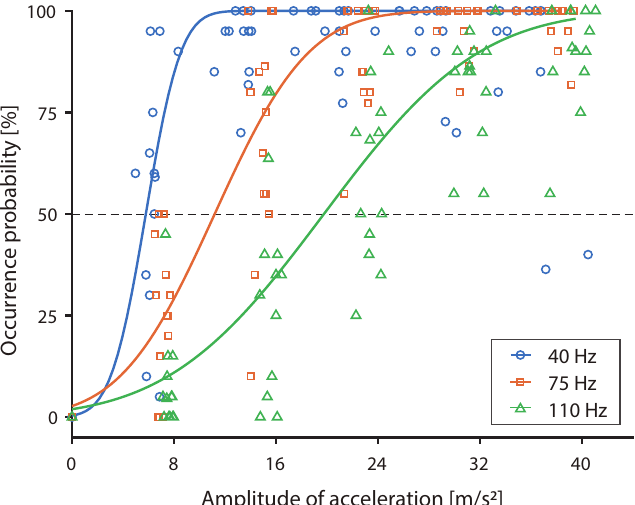
Figure 7. Scatter plot of the occurrence probability, amplitude of vibration acceleration, and typical examples of psychometric functions.